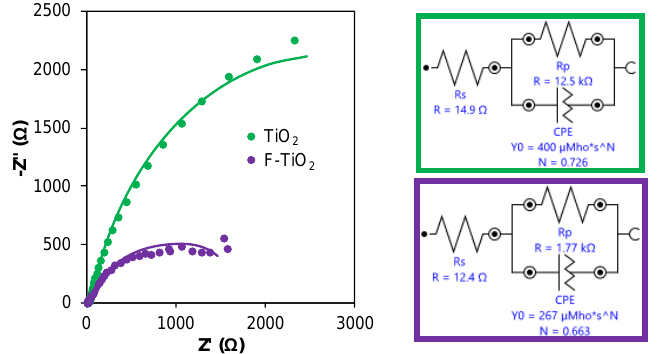
Figure 2. EIS measurement of TiO 2 (green) and F-TiO 2 (purple) with the fitting of the equivalent circuits. ECSA